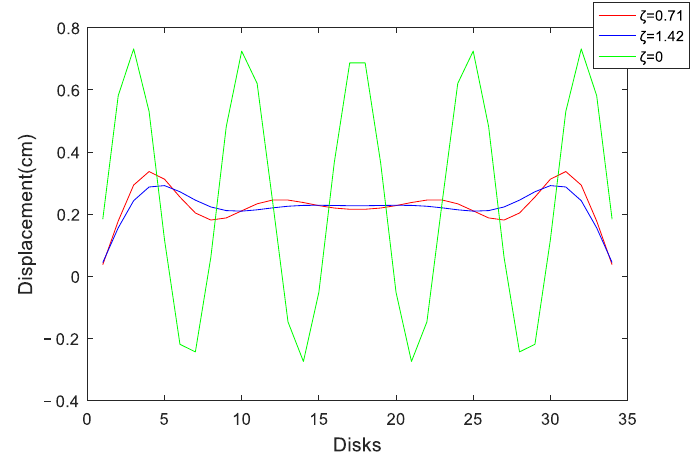
Figure 8. Displacement of each disk under different damping ratios. When t = 0.15 s, the acceleration change of each winding disk at this time is shown in Figure 9. Similar to the displacement waveform of each winding disk, the radial vibration acceleration waveform of the winding is in the shape of a ‘ valley ’ , which is also roughly consistent with the vibration mode law of the eighth order mode. The acceleration near both ends of the windings reaches a maximum value, about twice the acceleration of the middle part. With the increase of the damping ratio, the acceleration oscillation amplitude of each disk gradually decreases. Figure 9. Acceleration of each disk under different damping ratios.